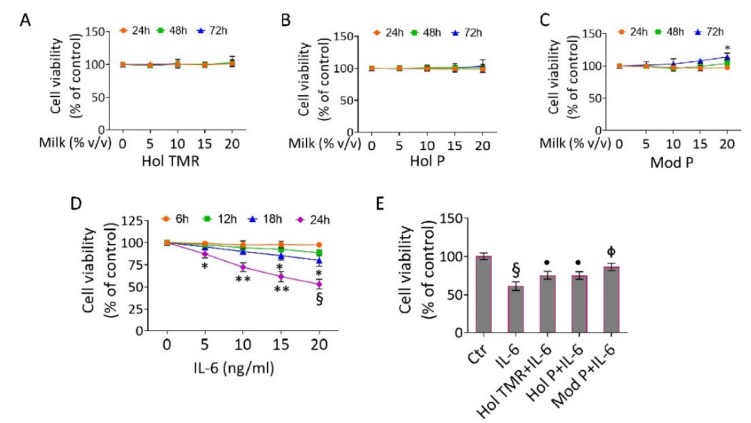
Figure 1. Milk extract effects on EC viability. EC viability was assayed after exposure to different volumes (0–20% v / v ) of ( A ) Hol TMR, ( B ) Hol P, and ( C ) Mod P milk up to 72 h or to ( D ) different concentrations (0–20 ng/mL) of IL-6 up to 24 h or ( E ) pretreated for 16 h with milk (20% v / v ) before starting stimulation for 24 h with IL-6 (20 ng/mL). Different colors and symbols mean different times of milk treatment. Cell viability was assessed by Cell Counting Kit-8 assay (Donjindo Molecular Technologies) and reported as % of control of n = 5 independent experiments. Control cells (0 or Ctr) were treated with the corresponding highest volume of HBSS-10 mM Hepes: * p < 0.05 vs. 0 mM or Ctr; ** p < 0.01 vs. 0 mM or Ctr; § p < 0.001 vs. 0 mM or Ctr; • p < 0.05 vs. IL-6; Φ p < 0.01 vs. IL-6.